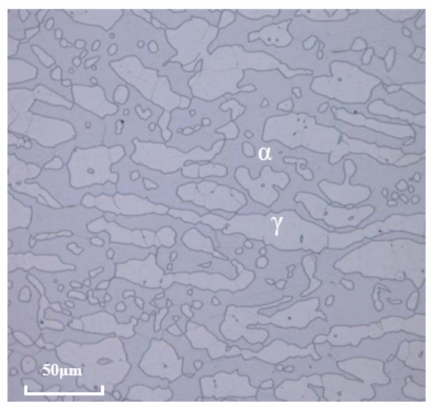
Figure 1. Metallographic morphology of 2205 duplex stainless steel for